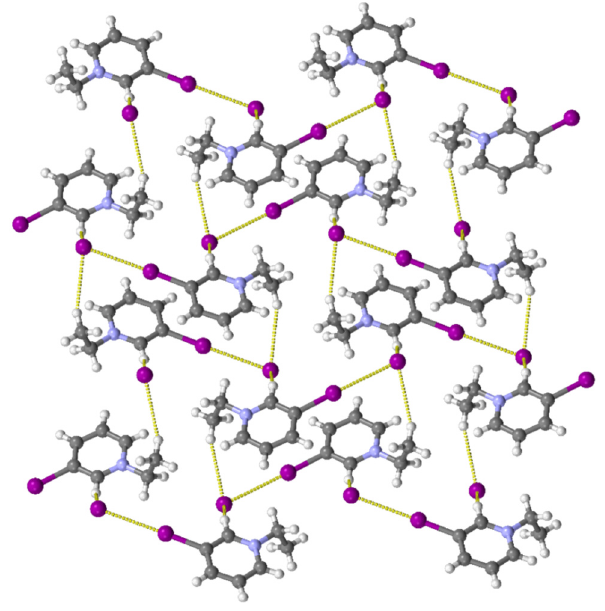
Figure 3. [ N -Et- 3-IPy ] + cations and iodide anions connected into layers through C − I ⋯ I − halogen